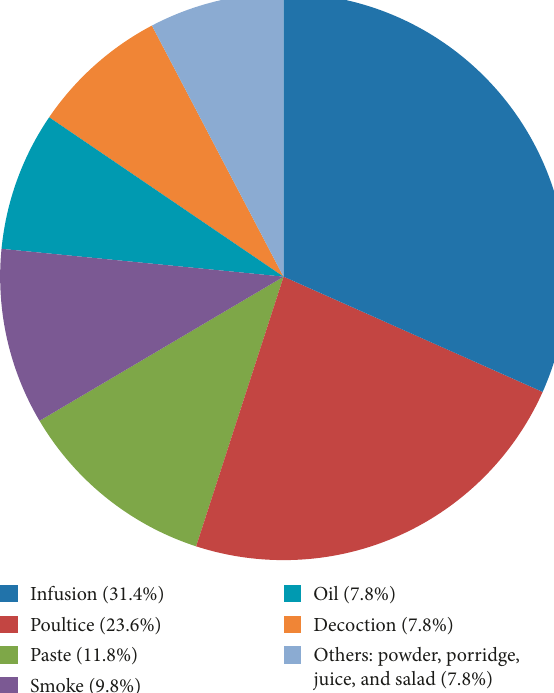
Figure 4: Mode of utilization reported to treat inflammatory conditions.